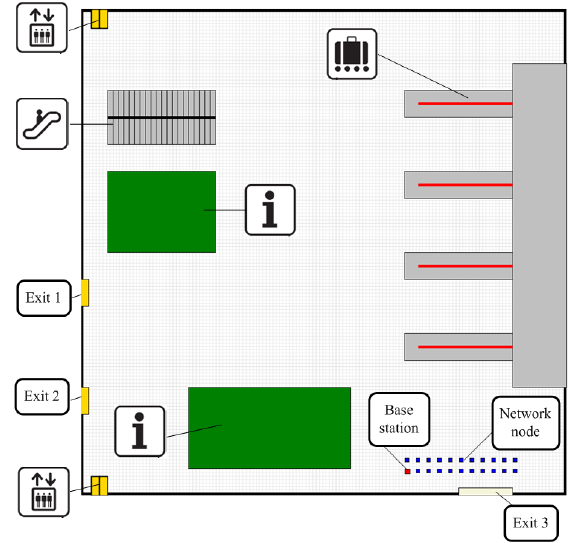
Figure 4. The arrival hall at the airport: sensing scene ( ROI ) and initial network